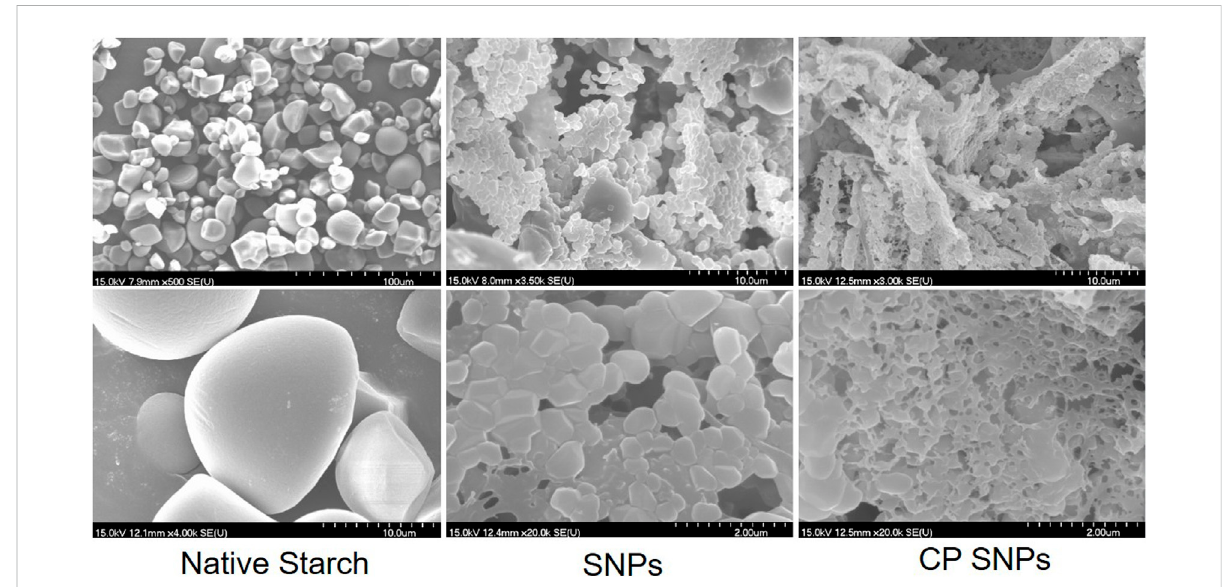
FIGURE 5 Field emission scanning electron micrographs (FE-SEM) of native starch, SNPs and CP